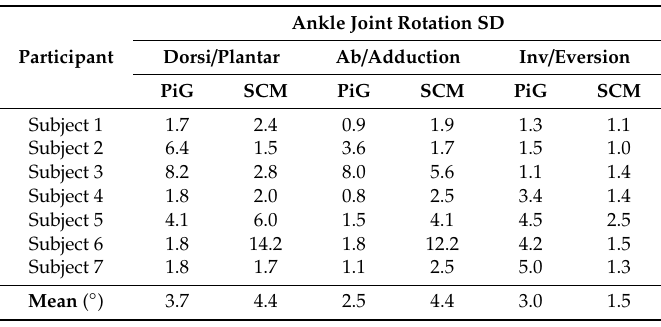
Table 6. Within-subject variability of ankle joint rotation over the sound gait cycle across three trials per participant as calculated by PiG and SCM is shown by the standard deviation,